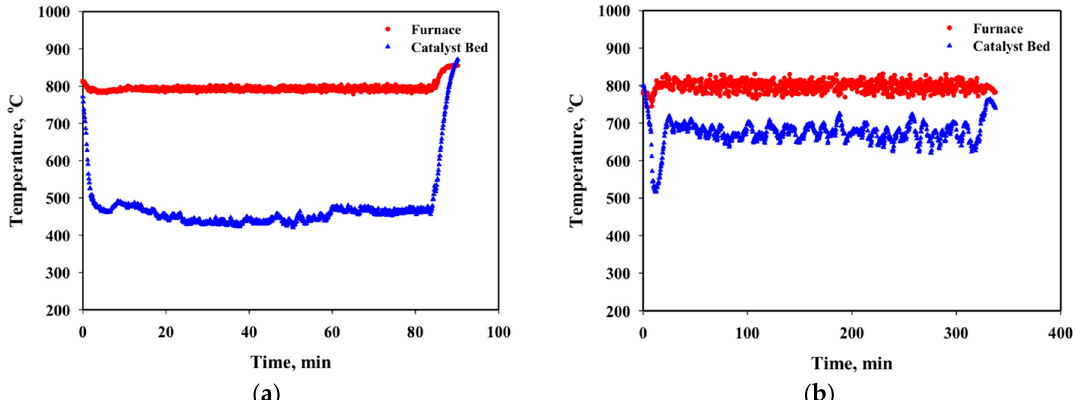
Figure 2. Temperature profile in the catalytic reactor during steam reforming and auto-thermal reforming over a Ni–Mg–Ce–Zr/Al 2 O 3 catalyst: ( a ) steam reforming of toluene (S/C = 3.0) at 800 °C and ( b ) auto-thermal reforming of toluene (S/C = 3.0, O 2 /C = 0.2) at 800